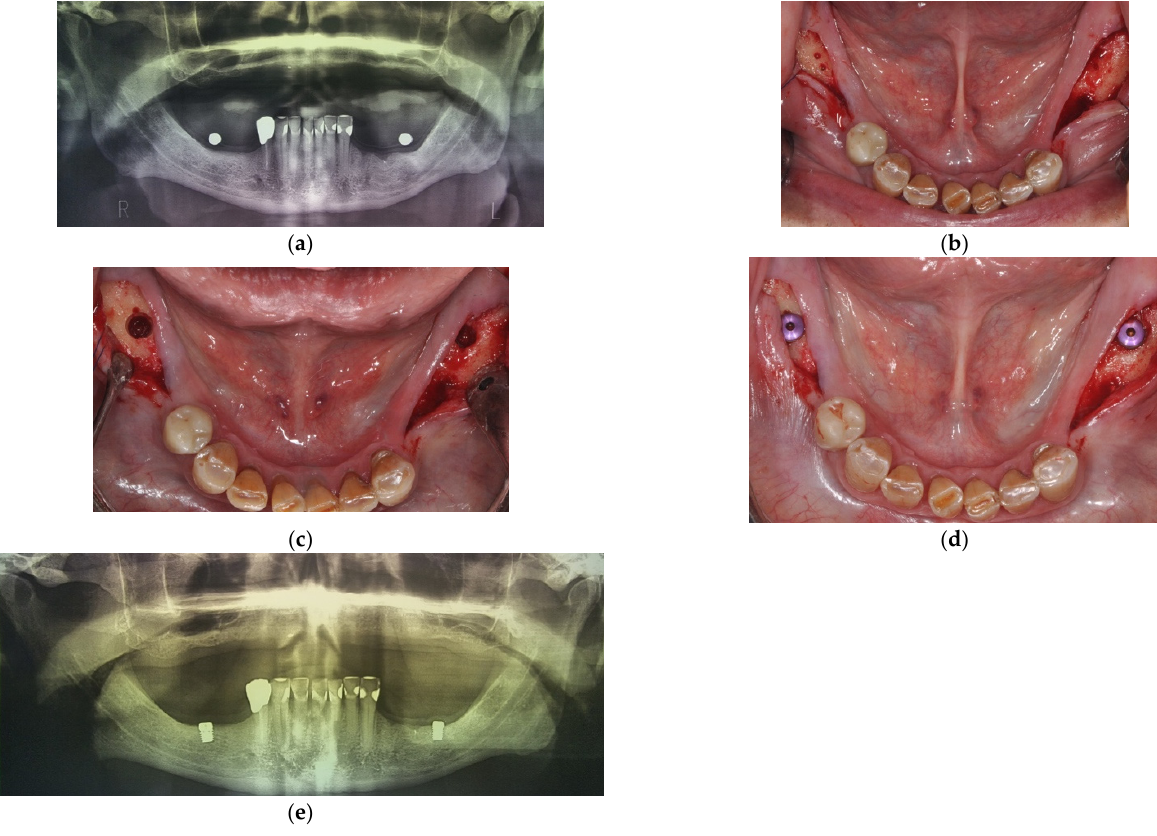
Figure 1. Surgical planning and implant placement. ( a ) Initial orthopantomogram (OPT) for implant planning, including metal balls for linear measurements; ( b ) preparation of the mucoperiosteal flap; ( c ) intraoral situation after the osteotomy; ( d ) implants with cover screws inserted; ( e ) post-surgical